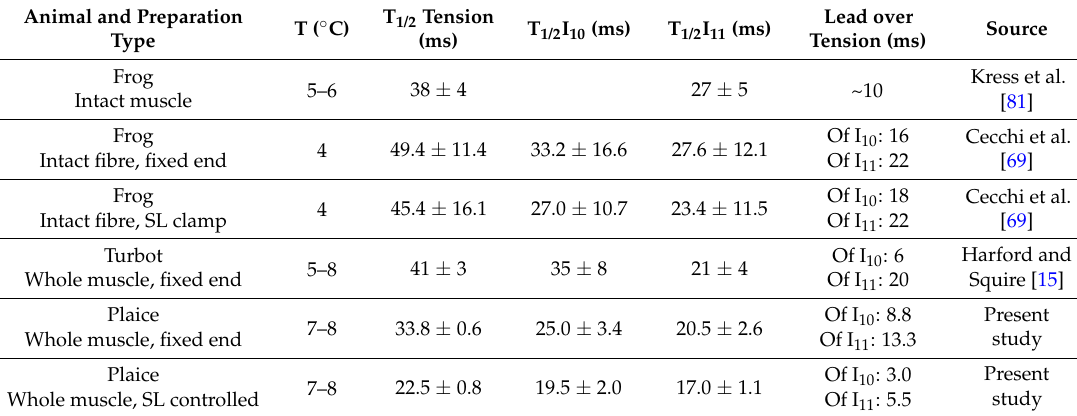
Table 1. Comparison of times for 50% change (T 1/2 ) during the rising phase of tetanic contractions in various example intact muscles, including plaice fin muscle in the present